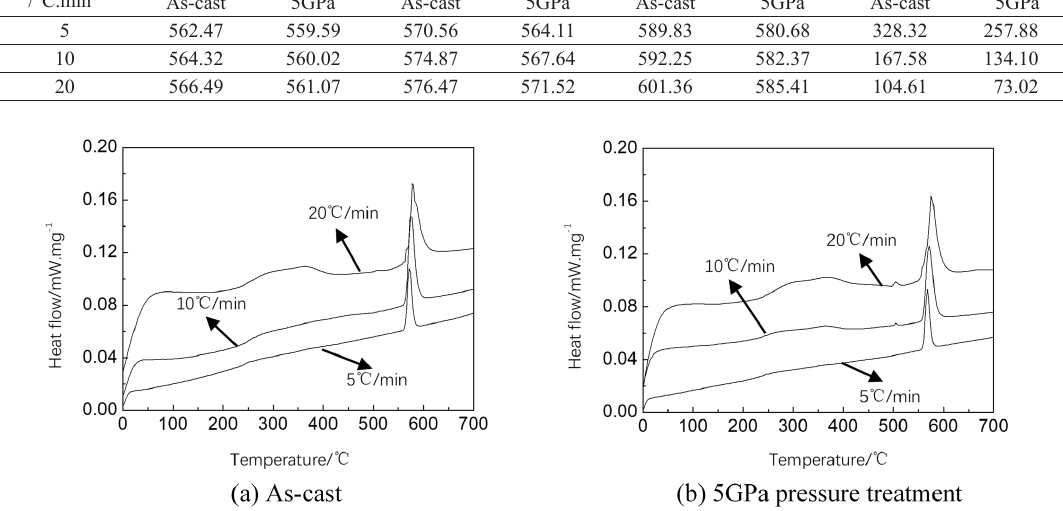
Table 2 - Phase transformation temperature and duration of α+γ different heating rates. Heating rate /°C.min